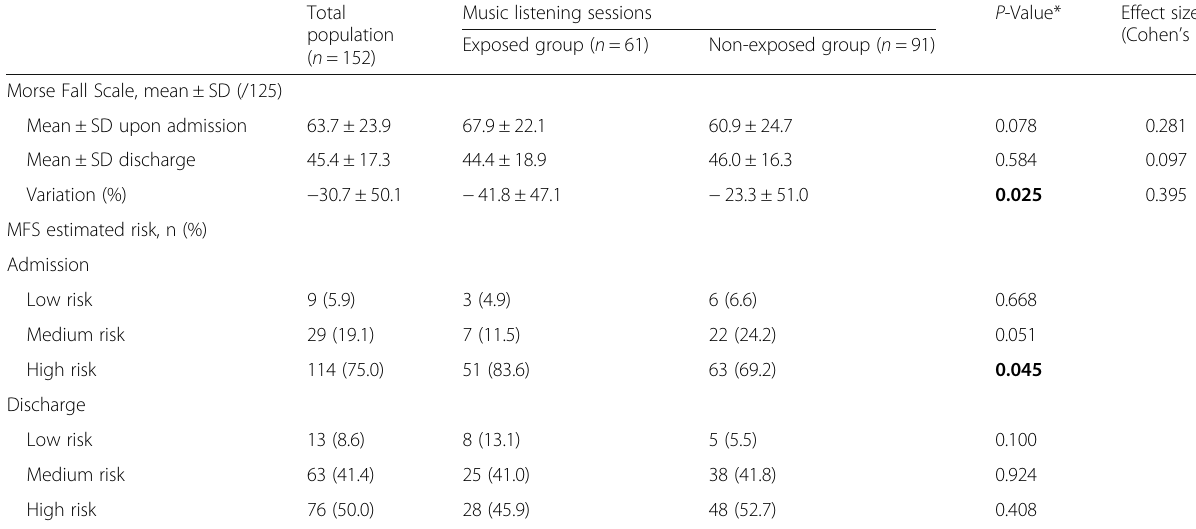
Table 2 Morse Fall Scale means and risk stratification of participants who were exposed and non-exposed to the music listening sessions at admission and discharge ( n = 152)